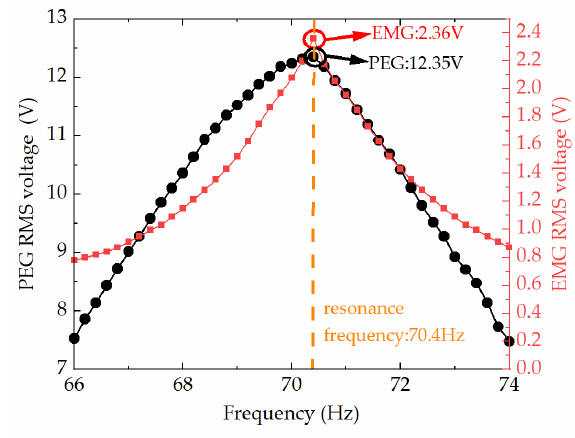
Figure 6. Frequency response of the array